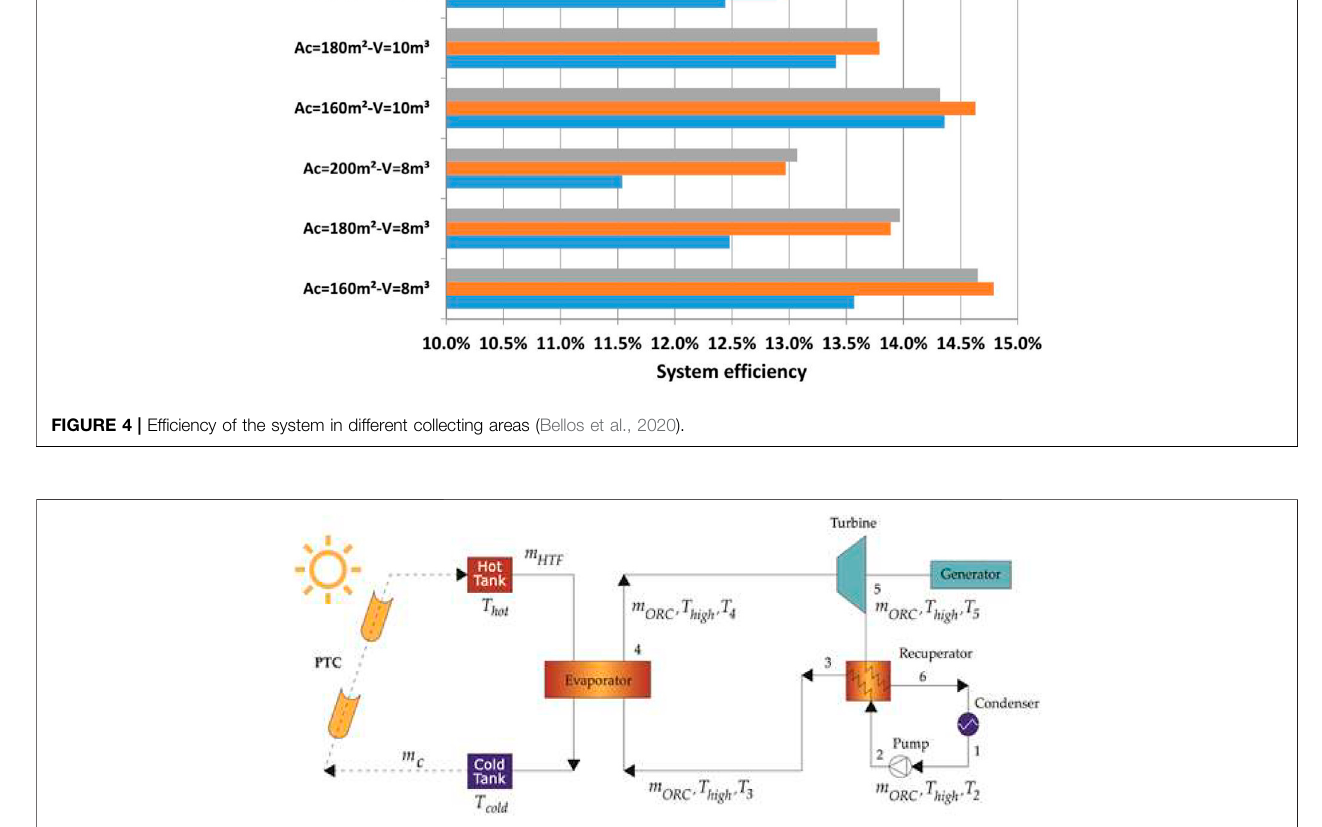
FIGURE 5 | Schematic of a solar ORC with two-tank thermal storage and recuperator (Yu et al., 2021).